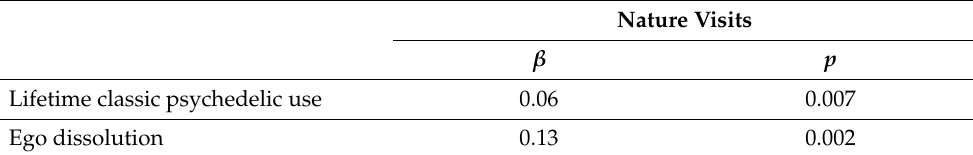
Nature Visits β p